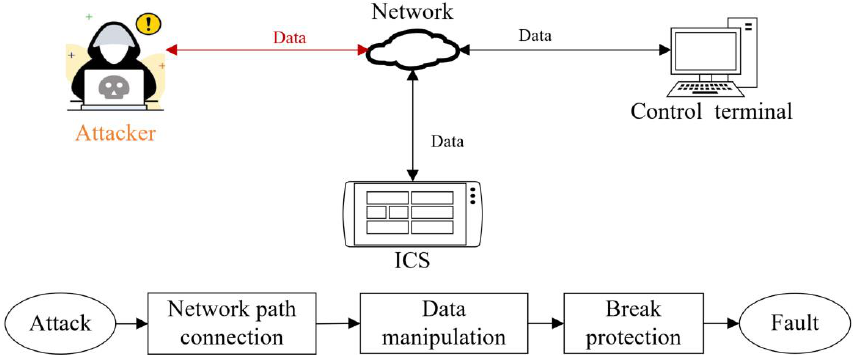
Figure 2. The processes of the attack path